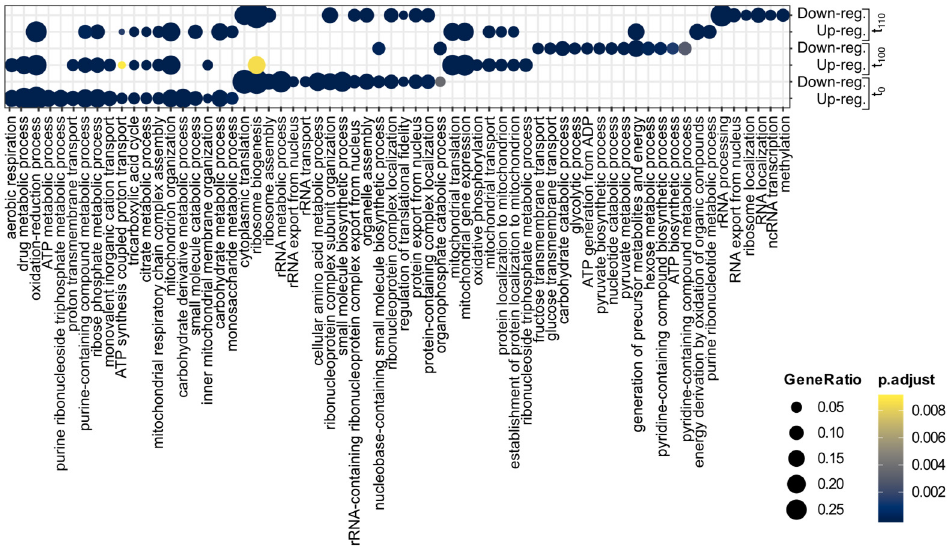
Figure 3. Gene ontology (GO) term enrichment analysis of deregulated genes in response to YPL in the yeast Saccharomyces cerevisiae under diversification or adaptive experimental evolution. GO enrichment is split for tested populations either up- or down-regulated.